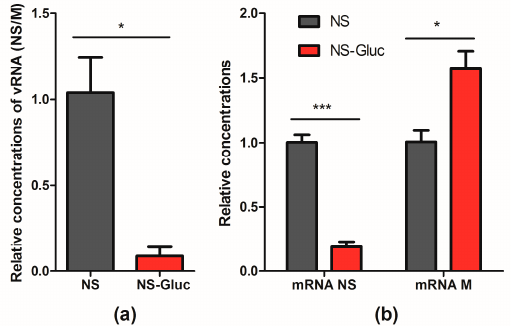
Figure 4. vRNA NS-Gluc is less competitive than natural NS in replication. RdRp assays were performed by cotransfecting pPolI-NS and pPolI-NS-Gluc respectively with pDZ-M as well as expression plasmids PA, PB1, PB2 and NP. At 30 h post transfection, the cells were harvested and total RNA were extracted. ( a ) The concentrations of vRNA NS and NS-Gluc were normalized to vRNA M, and the relative concentrations were presented; ( b ) The concentrations of mRNA NS, NS-Gluc and M were normalized to mRNA NP, and the relative concentrations were shown. The standard deviations were calculated based on three replicates. *** p < 0.001; * p < 0.05; students’ t test.